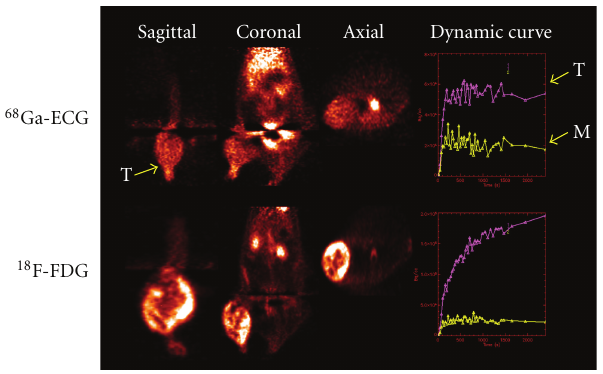
Figure 5: 18 F-FDG and 68 Ga-ECG PET imaging in mesothelioma- bearing rats (400 μ Ci/rat, iv, acquired 45 minutes). Computer- outlined regions of interest (ROI) (counts per pixel) for tumor and muscle at the corresponding time interval were used to generate a dynamic plot. Dynamic plot was from 0 to 45 minutes.